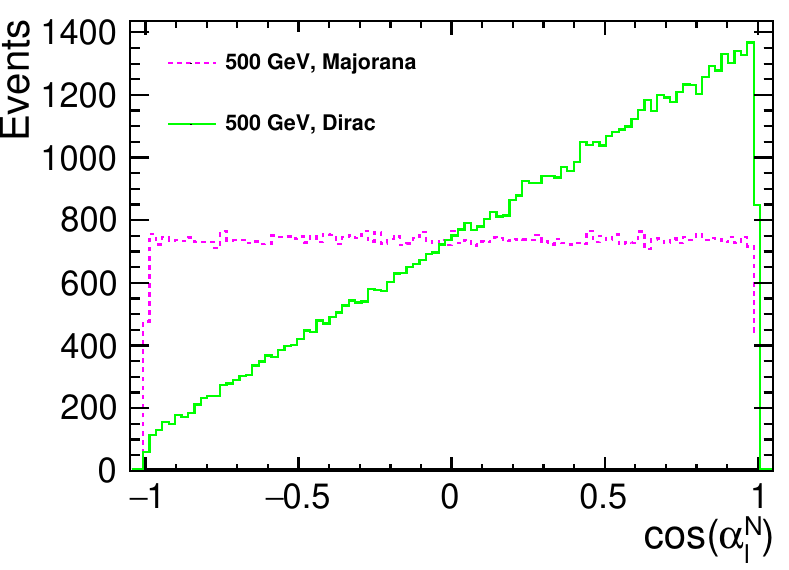
Figure 10. Distribution of the cosine of the lepton emission angle in the N rest-frame for the Majorana (pink dashed line) and the Dirac (green solid line) neutrinos with a mass of 500 GeV at CLIC3000 (generator level).